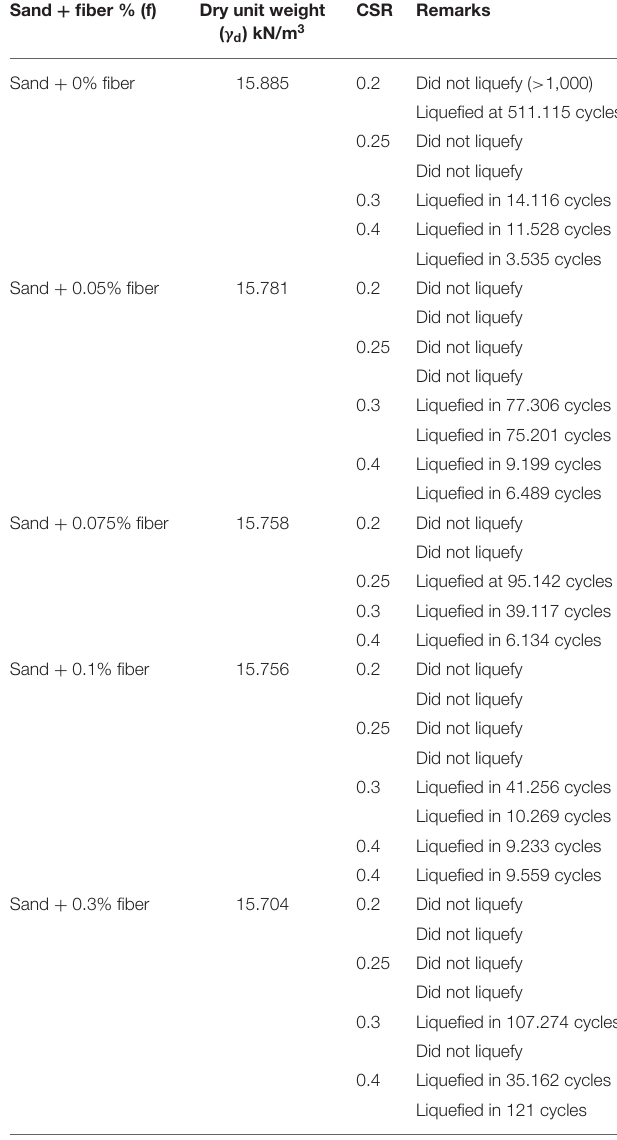
TABLE 4 | Cyclic triaxial tests on sand-fiber mixtures at initial effective confining pressure of 34.48